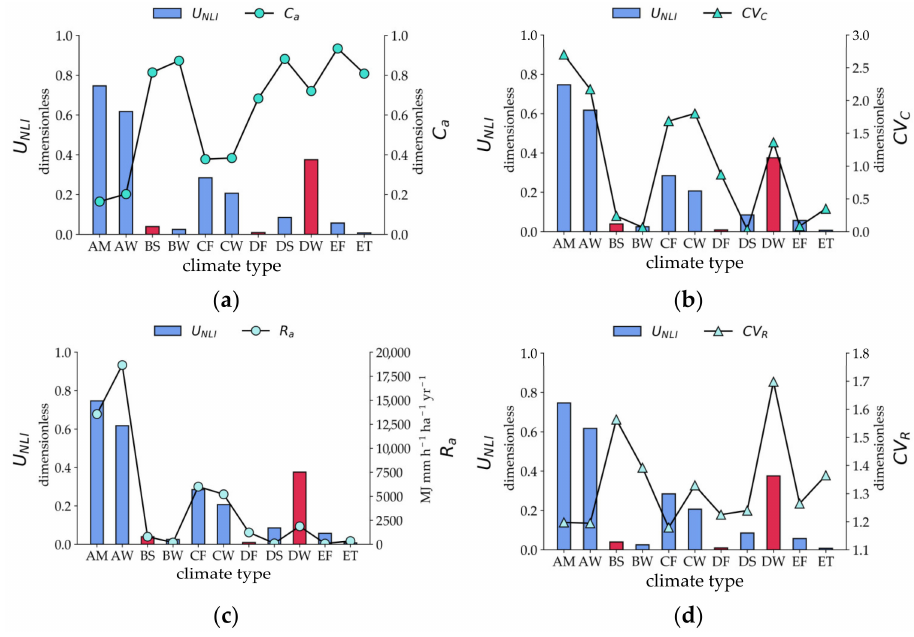
Figure 6. U NLI in different climate zones. ( a ) C a, ( b ) CV C, ( c ) R a, ( d ) CV